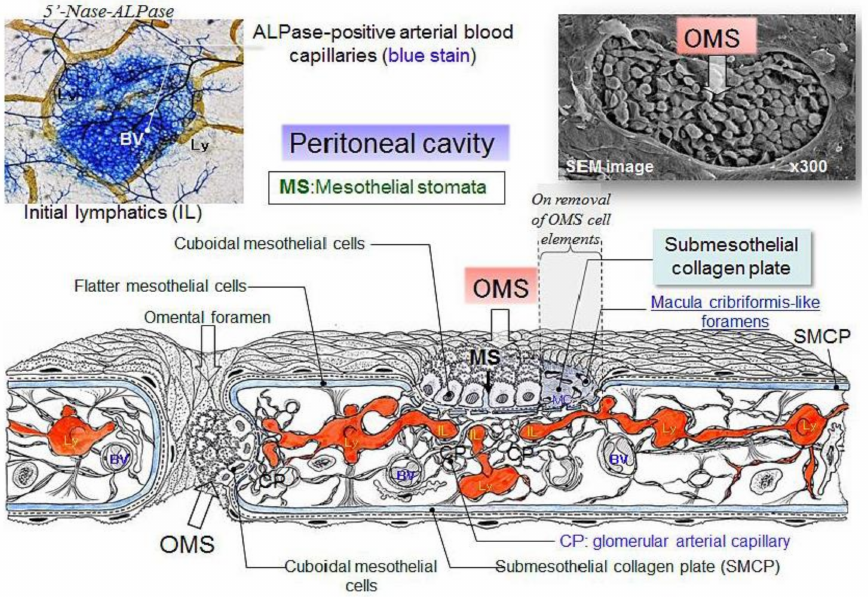
Figure 11. Schematic of the structures of omental milky spots (OMS). OMS are round or oval-shaped organs, covered with cuboidal mesothelial cells (right upper). Between the cuboidal mesothelial cells, stomata are connected to holes in the MC. Below the hole in the MC, there are glomerular-like blood capillaries and initial lymphatic vessels. (upper left). Ascites and inflammatory cells migrate from stomata to lymph–vascular system of the OMS through holes in the MC. Efferent lymphatic fluid absorbed from the OMS drain into the regional lymph nodes of the stomach.